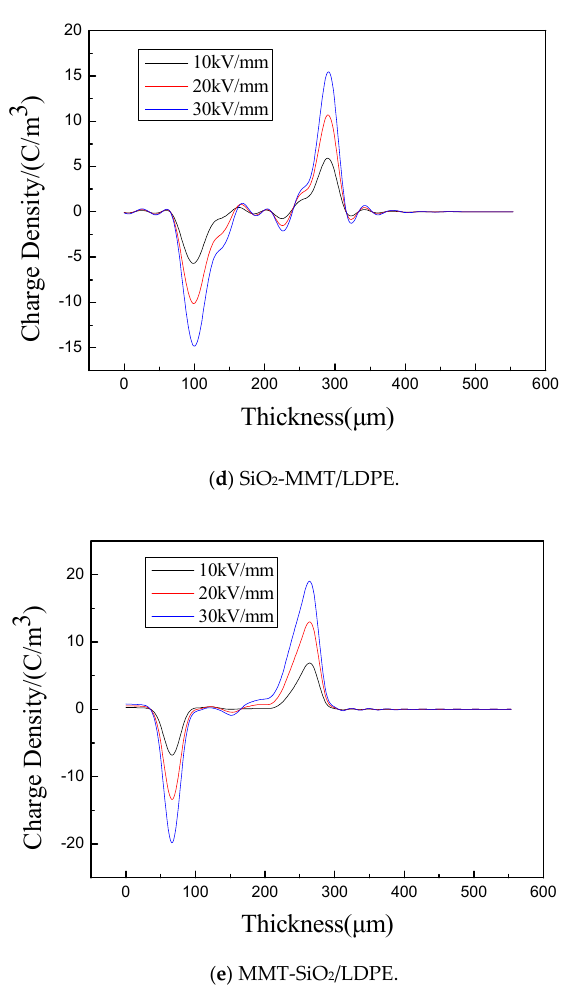
Figure 7. Space charge distribution of LDPE and composite materials under polarization electric field after 30 min. ( a ) Space charge distribution of LDPE; ( b ) Space charge distribution of MMT / LDPE; ( c ) Space charge distribution of SiO 2 / LDPE; ( d ) Space charge distribution of SiO 2 -MMT / LDPE; ( e ) Space charge distribution of MMT-SiO 2 /LDPE.